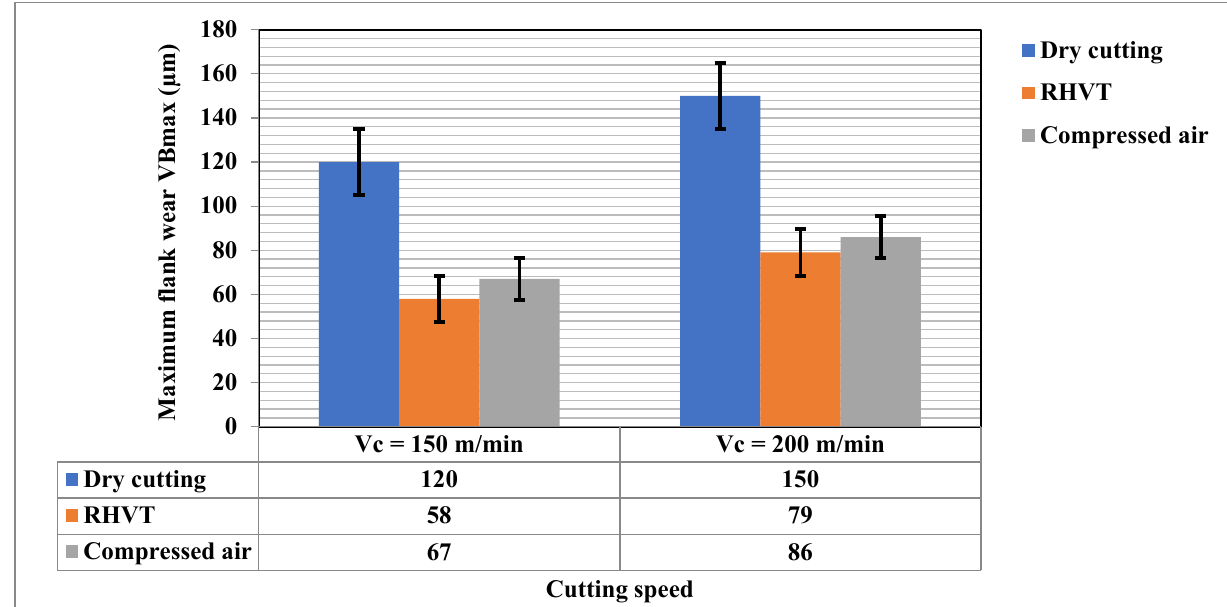
Figure 11. Depicts the consequence of cooling/lubrication environments on maximum flank wear VBmax at cutting speed Vc = 150 m/min, Vc = 200 m/min.